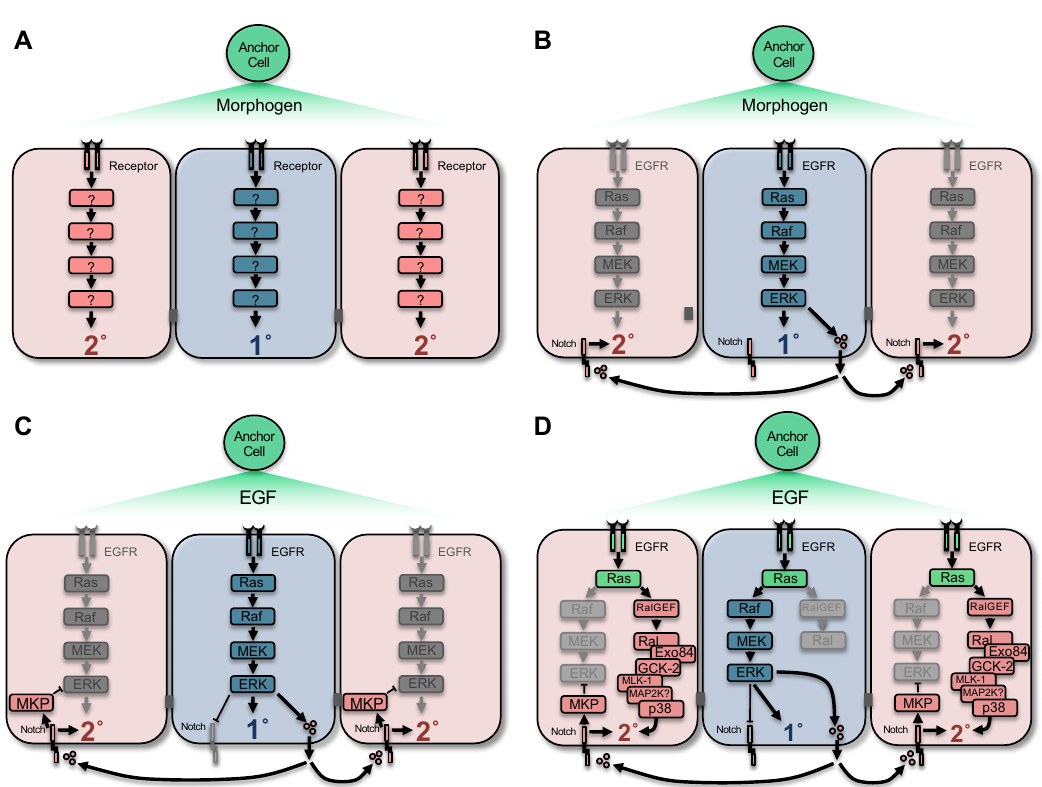
Figure 3. Models of C. elegans VPC fate patterning. (A) The Morphogen Gradient Model. Equipotent VPCs are patterned, by graded LIN-3/EGF (Morphogen) from the anchor cell (AC) through the activation of LET-23/EGFR (Receptor) based on position within the gradient. Yet in the absence of LIN-12/Notch the gradient cannot induce 2˚ fate, leading to the a Graded Signal plus Lateral Signal Model. (B) The Sequential Induction Model. In the response to the LIN-3, LET-23 activates the LET-60/Ras-LIN-45/Raf-MEK-2/MEK-MPK-1/ERK canonical MAP kinase signaling cascade to promote 1˚ fate. The induced presumptive 1˚ cells synthesizes redundant DSL/Notch ligands to laterally signal LIN-12/Notch activation to induce neighboring cells to assume 2˚ fate. ( C) Mutual Antagonism. Additional antagonistic mechanisms prevent VPCs from adopting inappropriate cell fates. In the presumptive 1˚ cell, activation of LET-23/EGFR causes internalization and degradation of LIN-12/Notch. In the presumptive 2˚ cells, the LIN-12 transcriptional target lip-1 is expressed. lip-1 encodes ERK phosphatase (a DUSP MAP kinase phosphatase; MKP) to abrogate MPK-1/ERK activation in presumptive 2˚ cells. ( D ) The Graded Signal, Lateral Signal and and Sequential Induction Models were reconciled (Zand et al. , 2011): all are thought to occur to pattern the VPC fates. During vulval fate patterning, LET-60/Ras switches effectors, from canonical LIN-45/Raf, which is necessary and sufficient for 1˚ fate induction, to non-canonical RGL-1/RalGEF-RAL-1/Ral that promotes 2˚ fate via activation of a GCK-2/MAP4K-PMK-1/p38 MAP kinase cascade in support of LIN-12/Notch [71]. The mechanism of this switch is unknown.